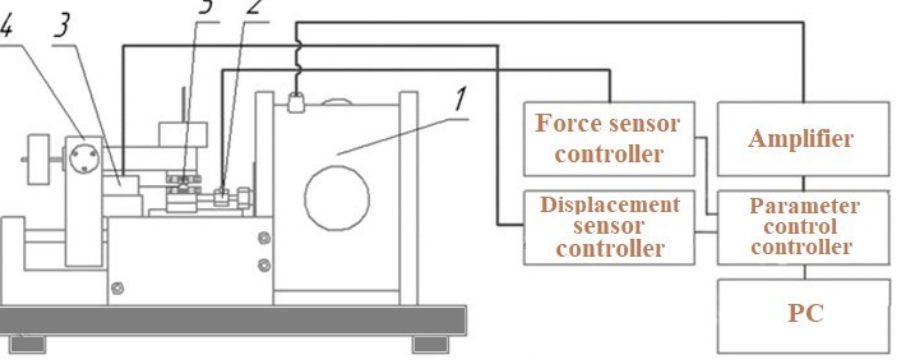
Figure 4. The scheme of the fretting wear test machine: 1—electromagnetic vibration device, 2—laser displacement sensor, 3—piezoelectric force sensor, 4—lever, and 5—contact zone.